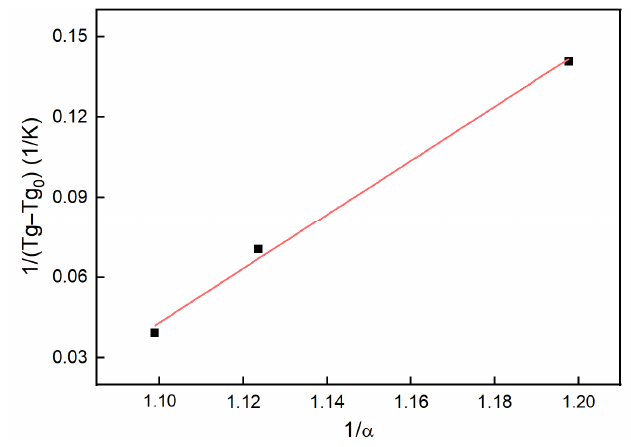
Figure 8. The fitting line based on the DiBenedetto equation.